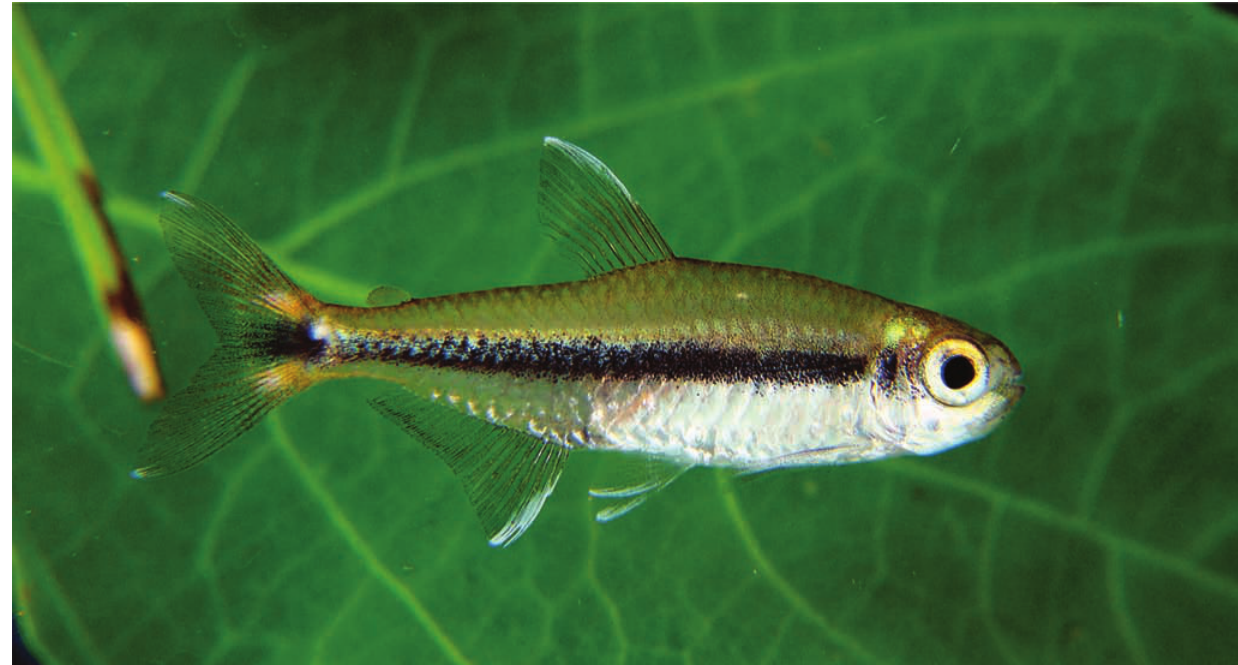
Fig. 5. Hyphessobrycon stegemanni , rio Tocantins basin, near Imperatriz, Maranhão, Brazil. Not preserved. Photo by D. Nielsen.